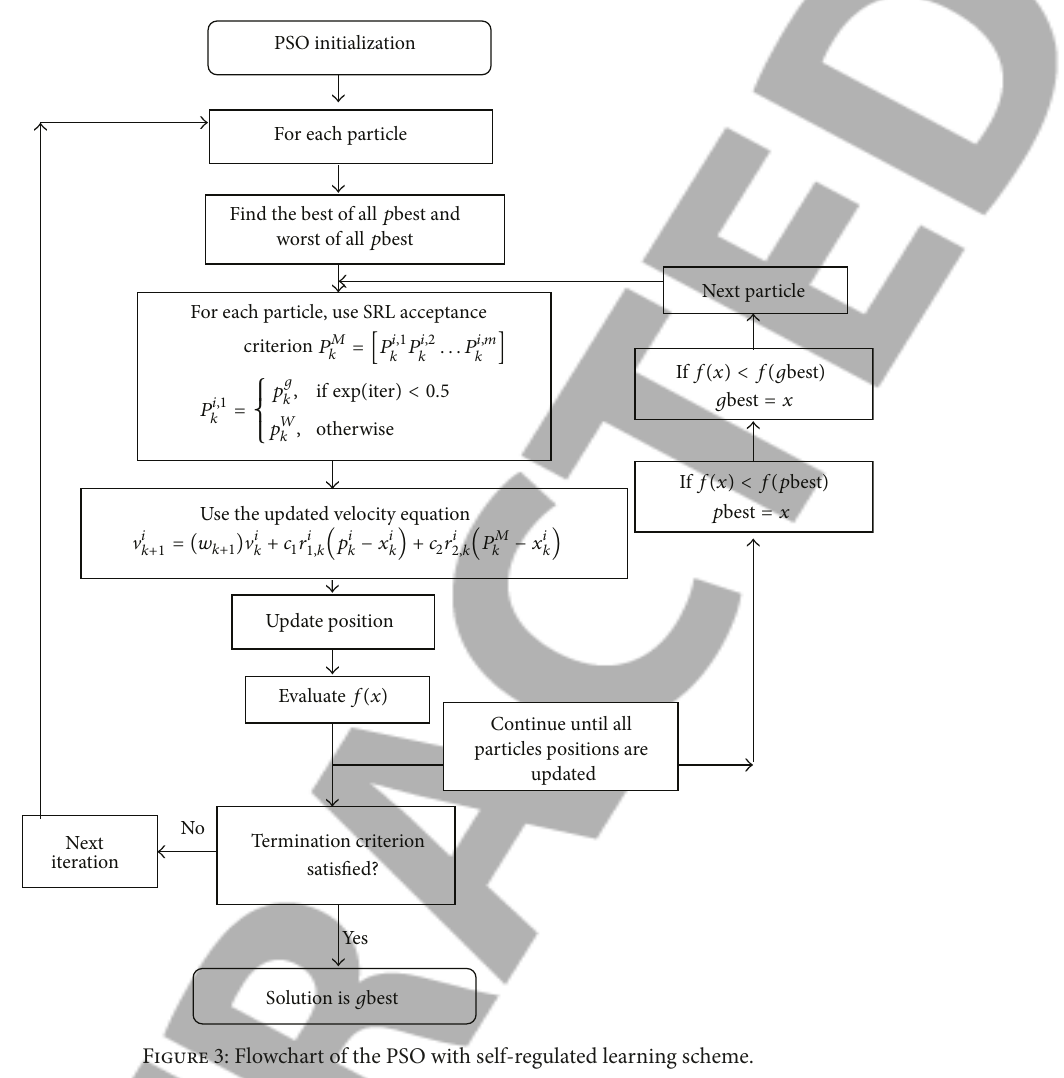
Figure 3: Flowchart of the PSO with self-regulated learning scheme.